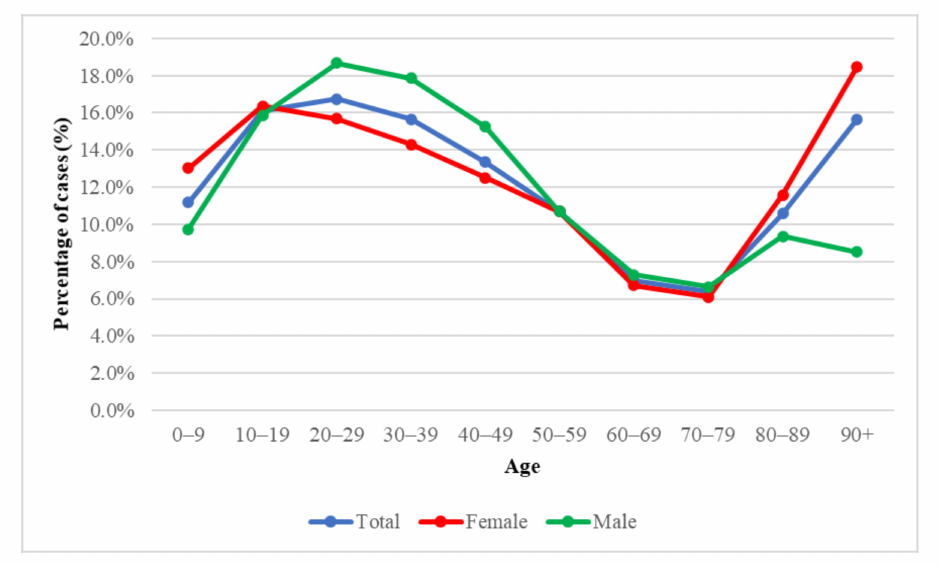
Figure 3. SARS CoV-2 infection by age and